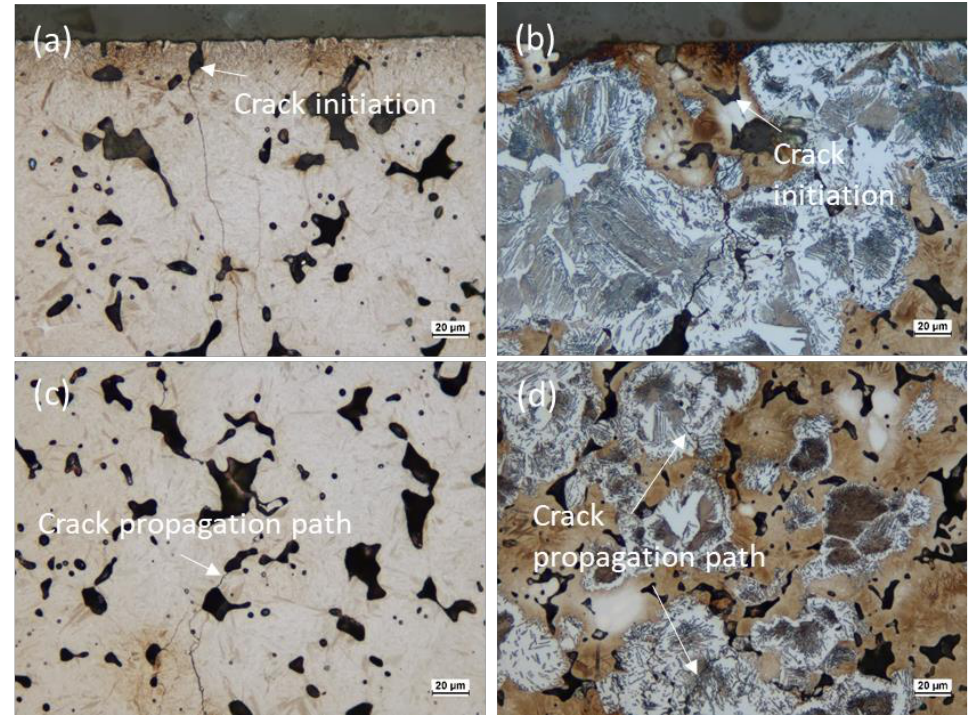
Figure 6. The origination and propagation of fatigue cracks: ( a ) crack initiation and ( c ) crack propa- gation path in Astaloy CrM, ( b ) crack initiation, and ( d ) crack propagation in Distaloy AE.